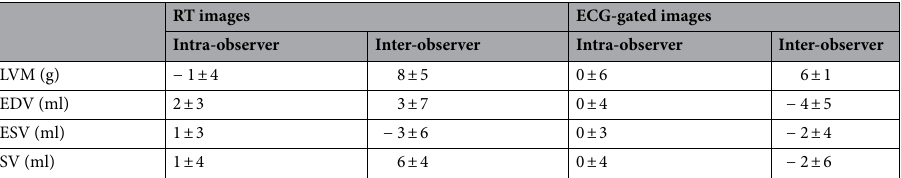
Table 3. Intra- and inter-observer variability between RT planimetric and ECG-gated images. Intra- and inter- observer variability testing in real-time (RT) images included construction of RT short-axis stack originating from 500 time-frame stacks. Values are presented as bias ± SD. RT real-time, ECG electrocardiogram, LVM left ventricular mass, EDV end diastolic volume, ESV end systolic volume, SV stroke